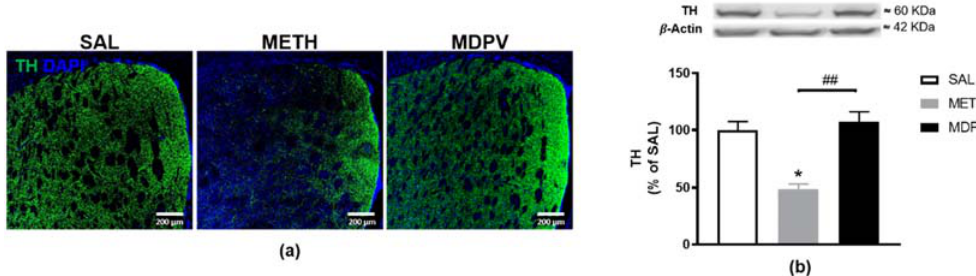
Figure 4. Effect of METH and MDPV binge paradigm on mice striatum TH protein density. ( a ) Rep ‐ resentative confocal images of striatal sections, co ‐ labelled with anti ‐ TH antibody (green) and DAPI (blue) (scale bar: 200 μ m; n = 3); ( b ) representative western blot and quantification of striatal TH protein density. Results were normalized with β‐ actin and expressed as mean % of saline ± S.E.M ( n = 5–7). Statistical comparisons were made using the Kruskal–Wallis test followed by Dunn’s multi ‐ ple comparison test (* denotes differences between SAL and METH or MDPV and # denotes differ ‐ ences between METH and MDPV. *, p < 0.05; ## , p < 0.01).